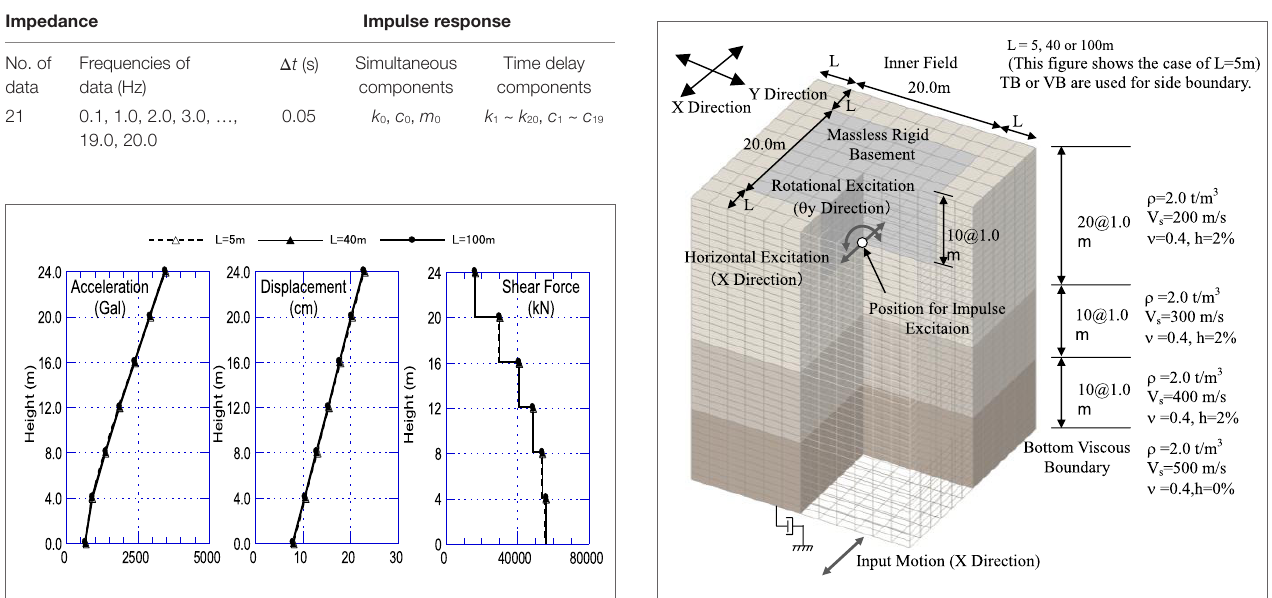
FigUre 6 | Maximum responses of building (TB, sh problem) . FigUre 8 | analysis model for soil impedance and input motion